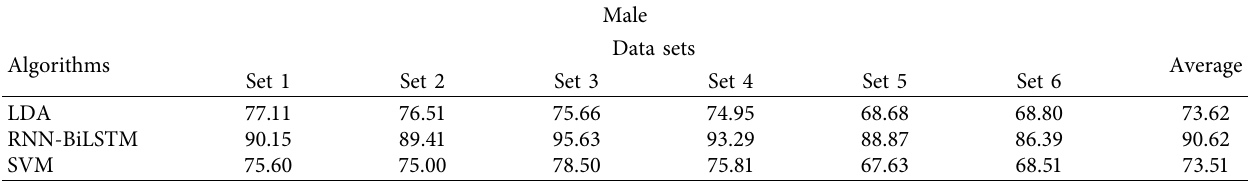
Table 2: Average and recall values for proposed models to identify the male voice samples.